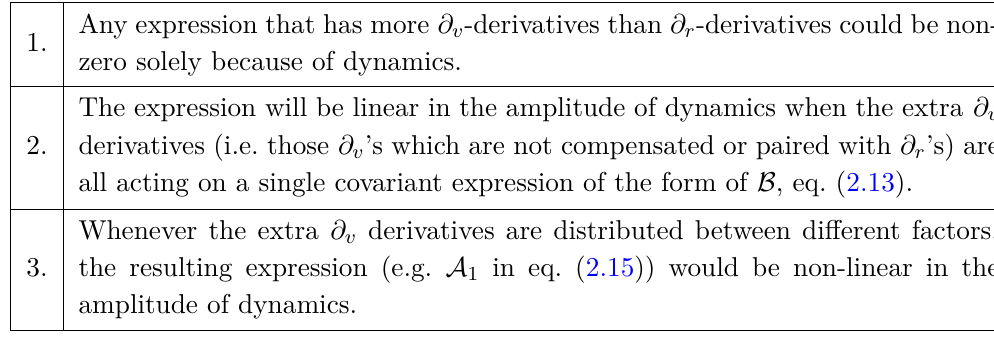
Table 2 . Distribution of ∂ v -derivatives and non-linearities in amplitude